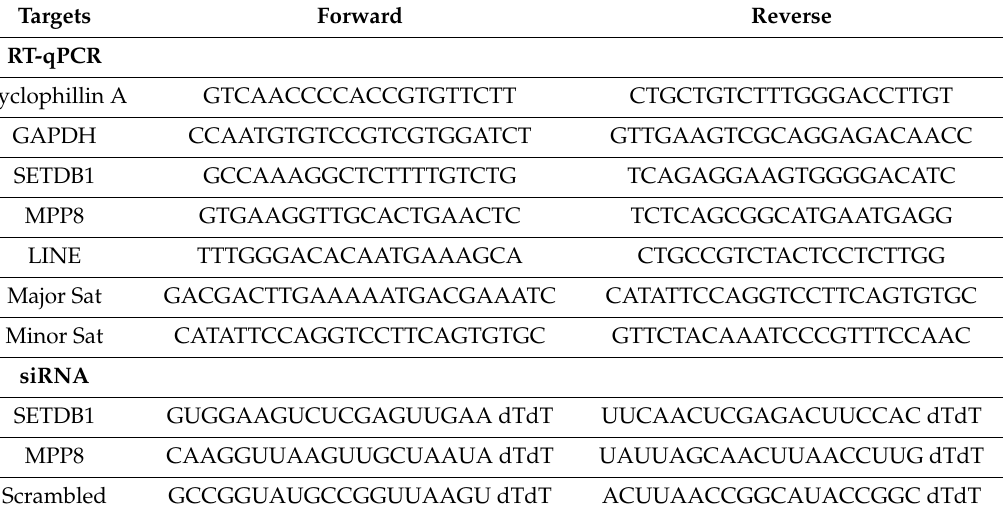
Table 1. Primer and siRNA